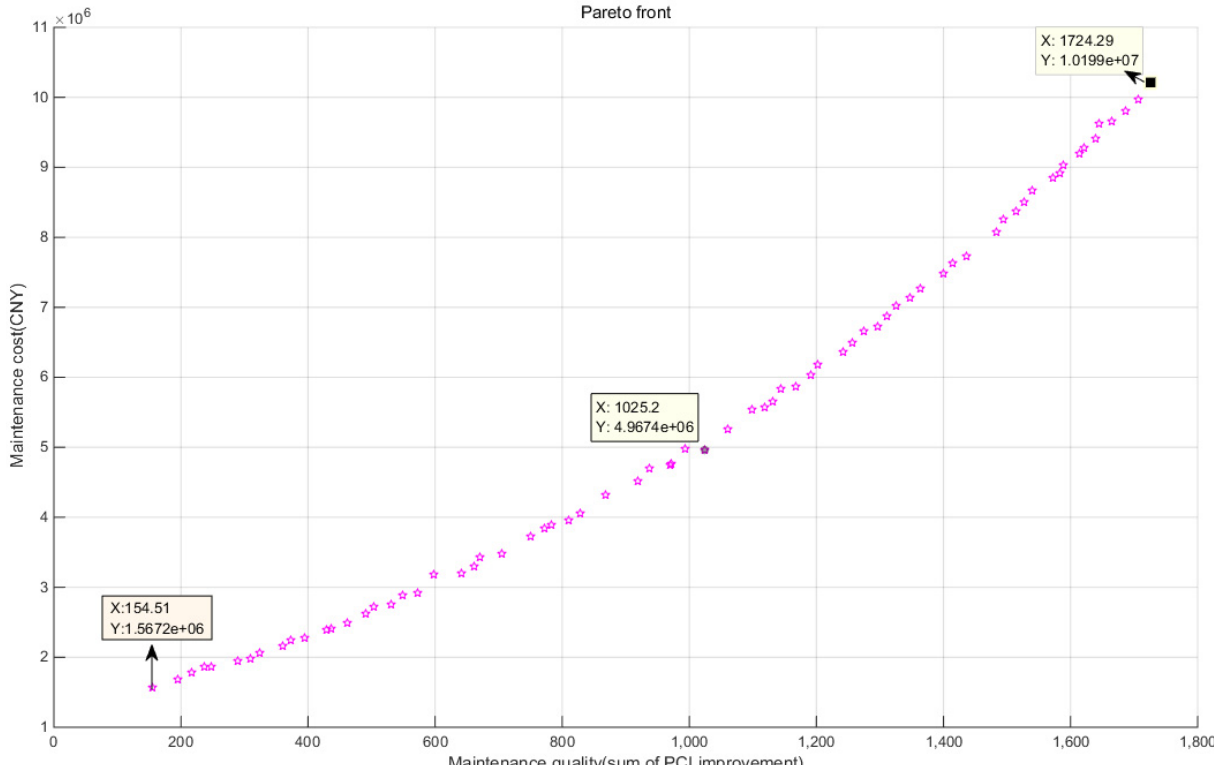
Figure 3. Pareto front of the MBMMQ model solved by genetic algorithms.